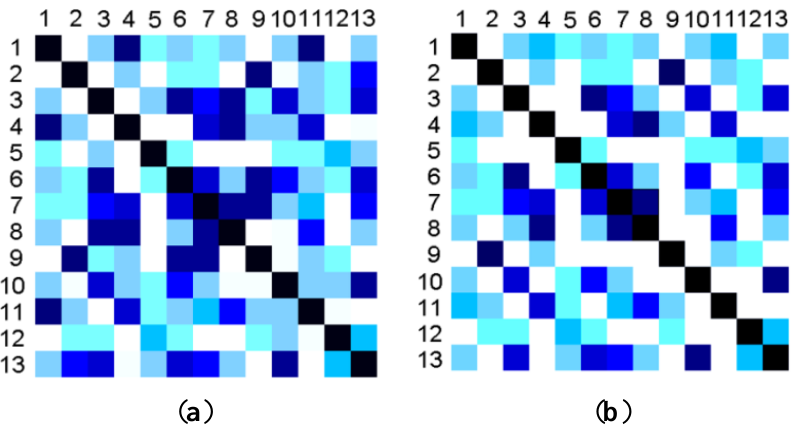
Figure 5. The comparison of similarity matrixes for 13 primitive actions between original features and selected features. The hue demonstrates the similarity between any two actions. ( a ) The similarity matrix for the original features; ( b ) The similarity matrix for the selected features.